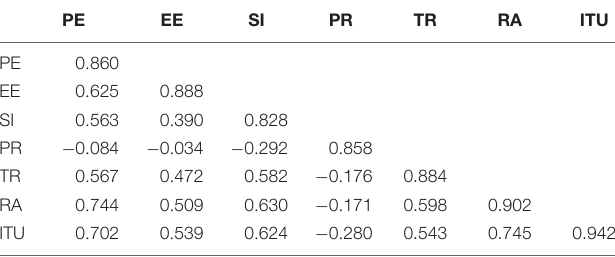
TABLE 2 | Discriminant tests.